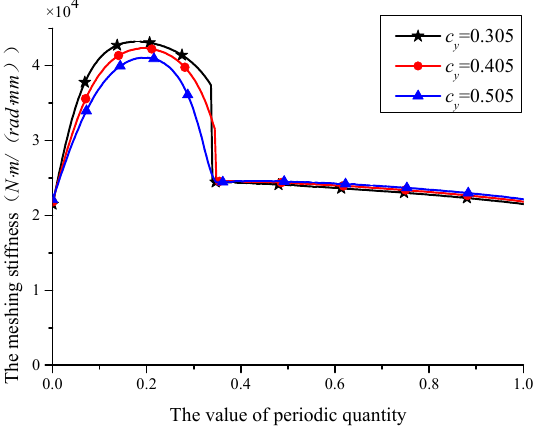
Figure 26. Influence rule of c y on meshing stiffness.